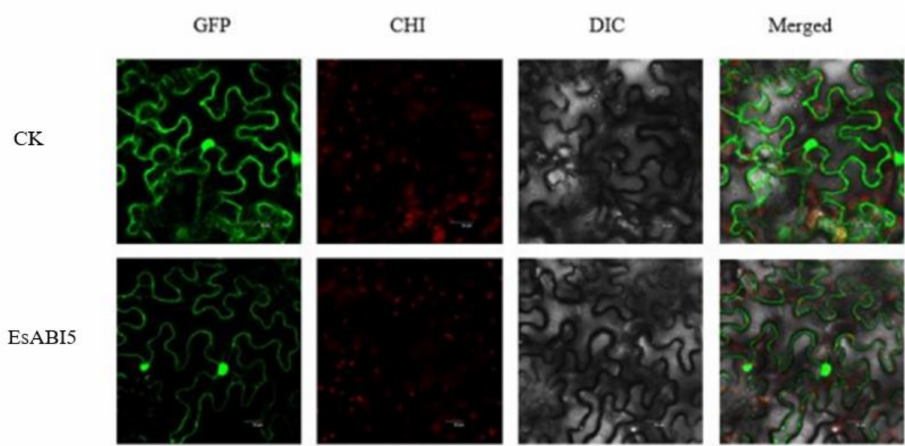
Figure 5. Subcellular localization of EsABI5 protein in tobacco epidermal cells: GFP, green fluores- cence protein under dark field; CHI, chloroplast autofluorescence; DIC, cell morphology of the lower epidermis of a tobacco leaf under bright field. Merged: overlay of GFP, CHI, and DIC.